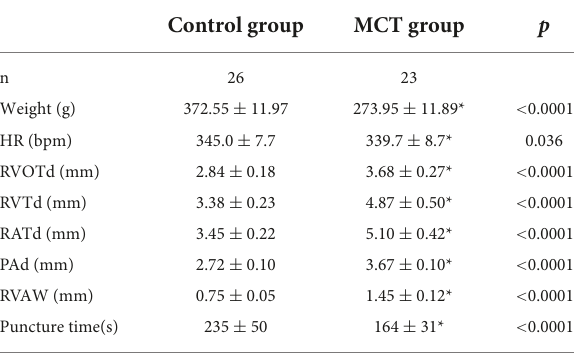
TABLE 1 The detailed parameters of pulmonary artery pressure were measured by puncture in the control group and the monocrotaline (MCT) group.